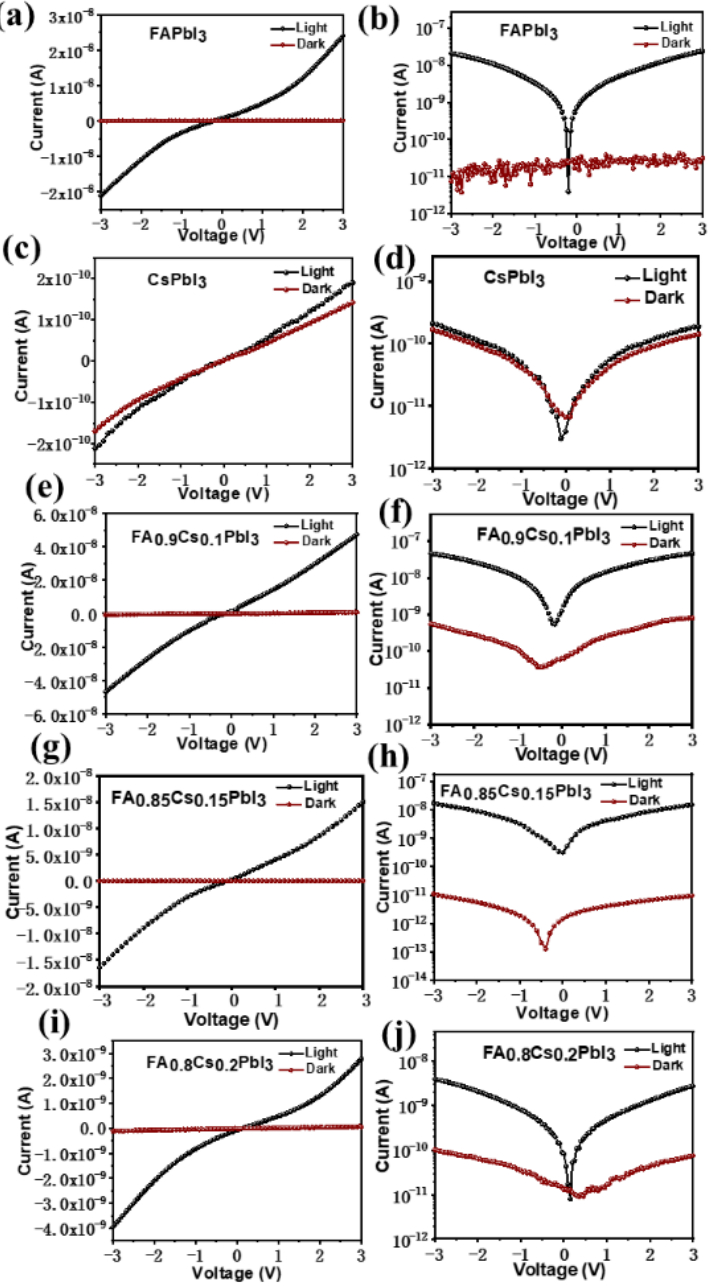
Figure 4. ( a , c , e , g , i ) I-V curve of the FA 1 − x Cs x PbI 3 thin-film device in light (black) and dark (red) con- ditions, respectively; ( b , d , f , h , j ) correspond to the ( a , c , e , g , i ) after logarithmic processing,